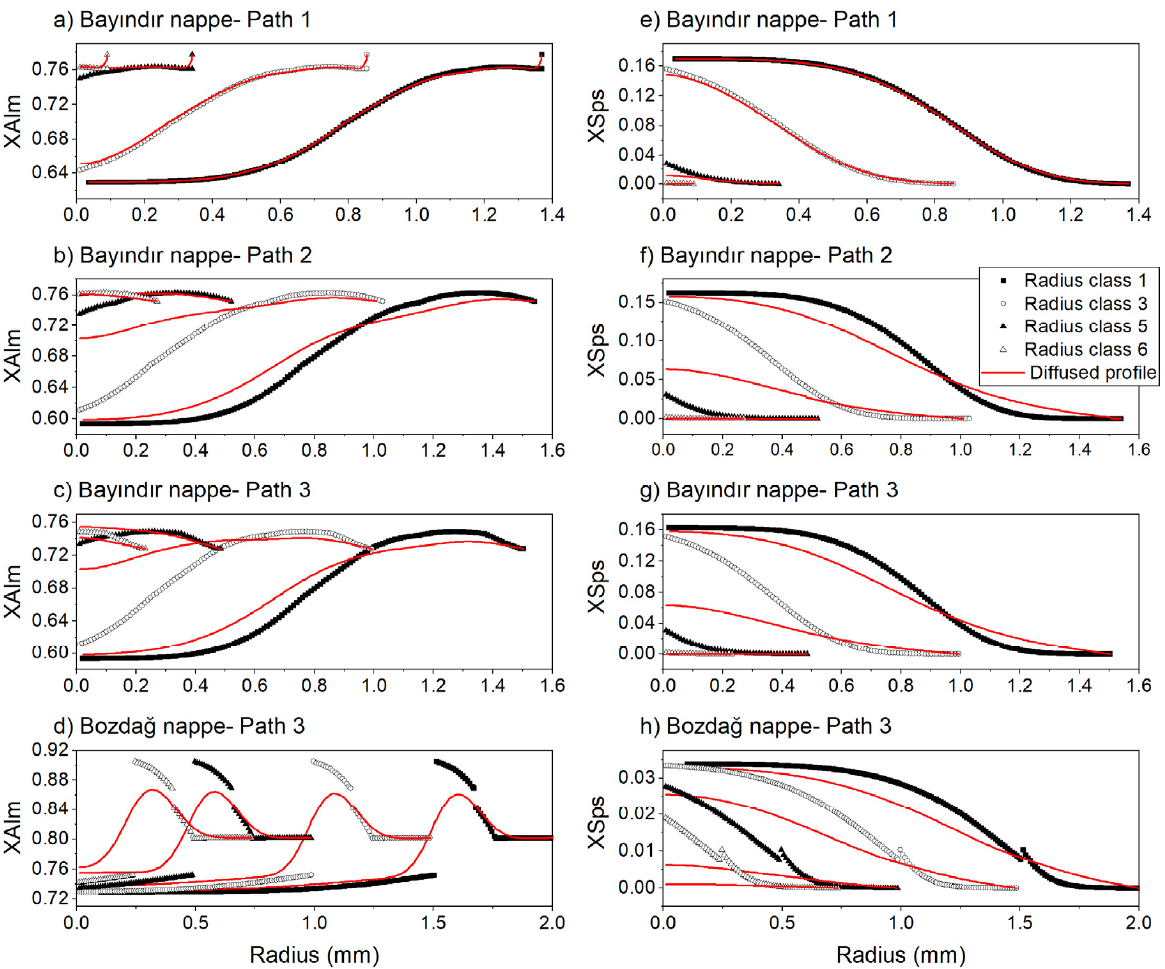
Figure 9. Theria_G predicted almandine and spessartine compositions in average samples from the Bayındır and Bozda˘g nappes (Menderes Massif, Turkey). ( a – h ) depict the predicted original prograde-growth composition for different radii classes (symbols), and diffusion-modified composition (solid red lines) as the sample evolves on one of the three specified P-T-t trajectories shown in Figure 4a.